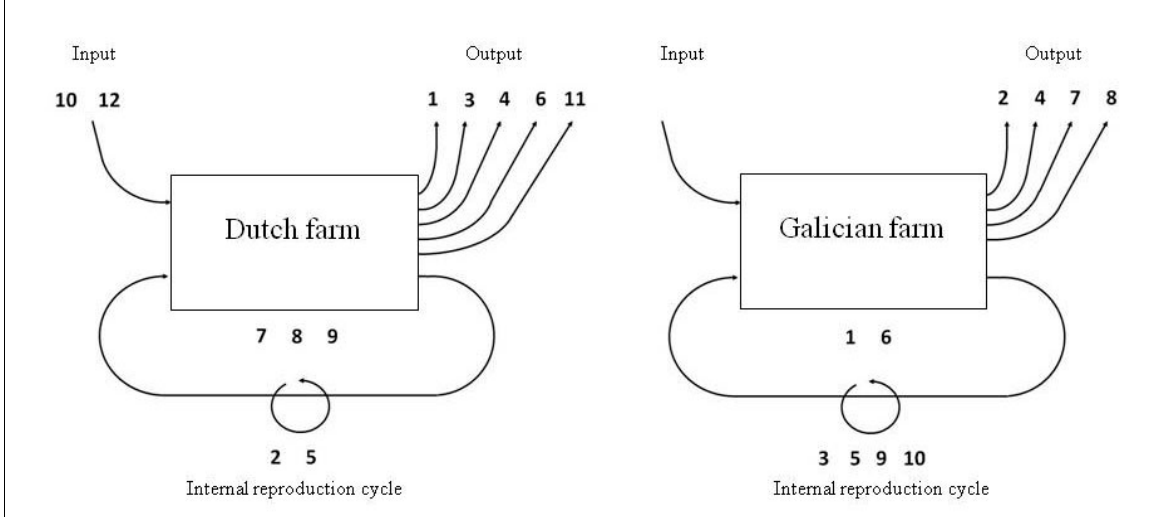
Figure 2. Transformation of Input-Output Relations: The Novelties Created at Both Farms